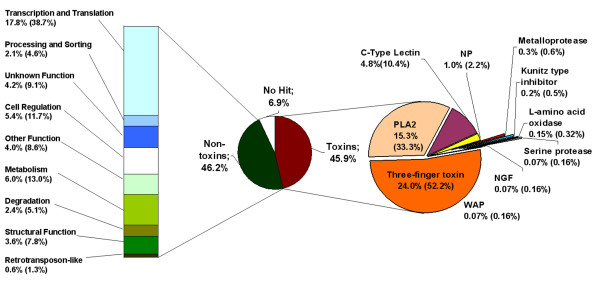
Relative proportion of each category of product found in M. corallinus venom gland transcriptome. Toxin, Non-toxin and No Hit categories are, respectively, clusters matching GenBank snake toxin sequences, non snake toxin sequences, and any sequence with an e-value < 10e-05 on Blastx search or inconclusive nucleotide matches on Blastn. Non-toxins are categorized by their cellular function, whereas toxins by their structural type. Percentages of total ESTs and of the ESTs in the category (in parentheses) are presented.